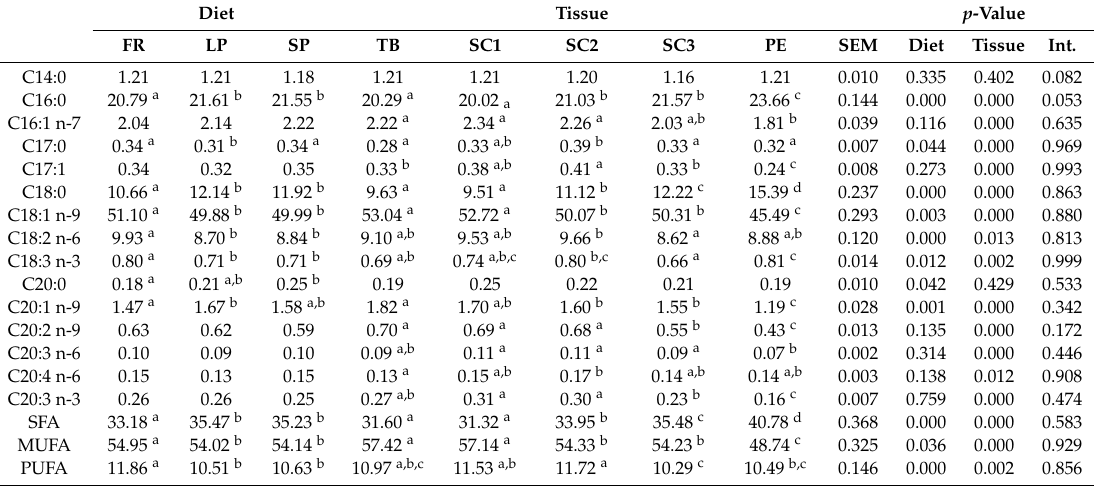
Table 3. E ff ect of diet and adipose tissue on fatty acid composition (%) of the backfat and perirenal fat from Iberian pigs. Diet Tissue p -Value